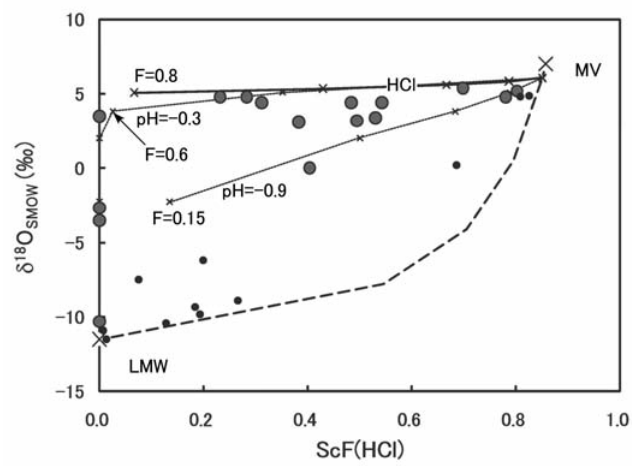
Figure 11. Correlation between the δ 18 O values of H ratios in the fumarolic gases from site J. Bold horizontal line, trend during the partial condensation of the vapor, where the condensed liquid contains H + and Cl – ions with a common molarity. Thin dashed curves, trends of partial condensation, for which the pH of the condensed liquid phase is fixed at –0.3 or –0.9. Bold dashed curve, mixing line between the MV and the